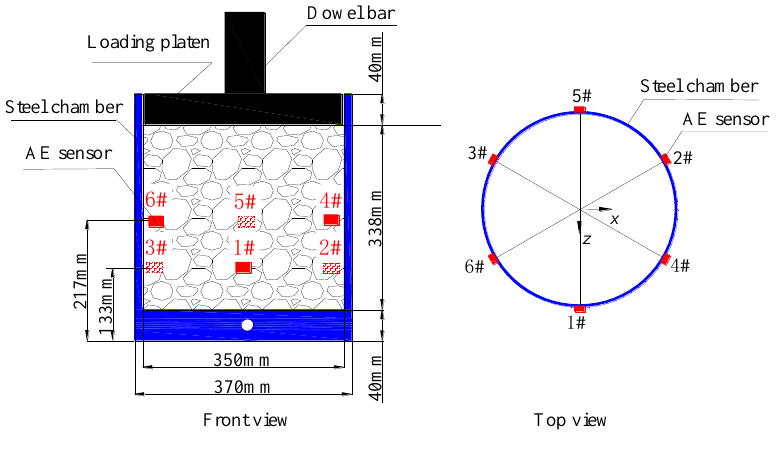
Figure 5. Layout diagram of sensors.